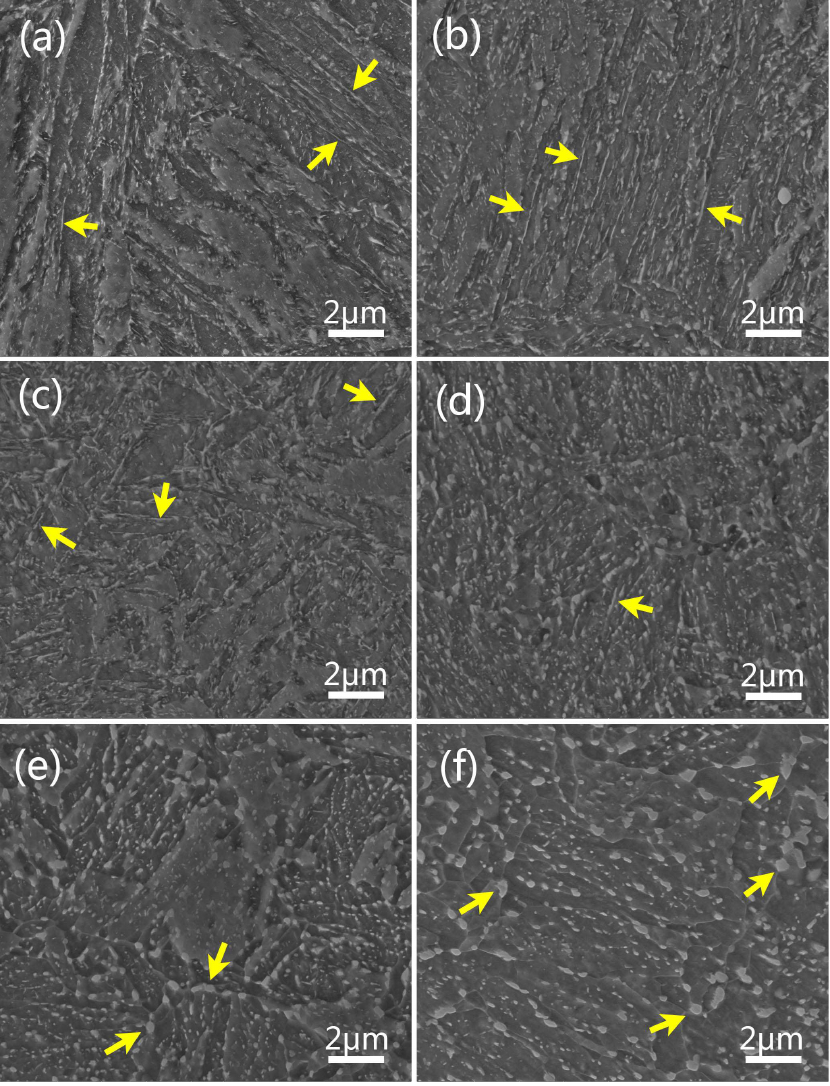
Figure 1. SEM microstructures of 42CrMo4-V steel tempered at: ( a ) 570 °C; ( b ) 600 °C; ( c ) 630 °C; ( d ) 660 °C; ( e ) 690 °C; ( f ) 720 °C.